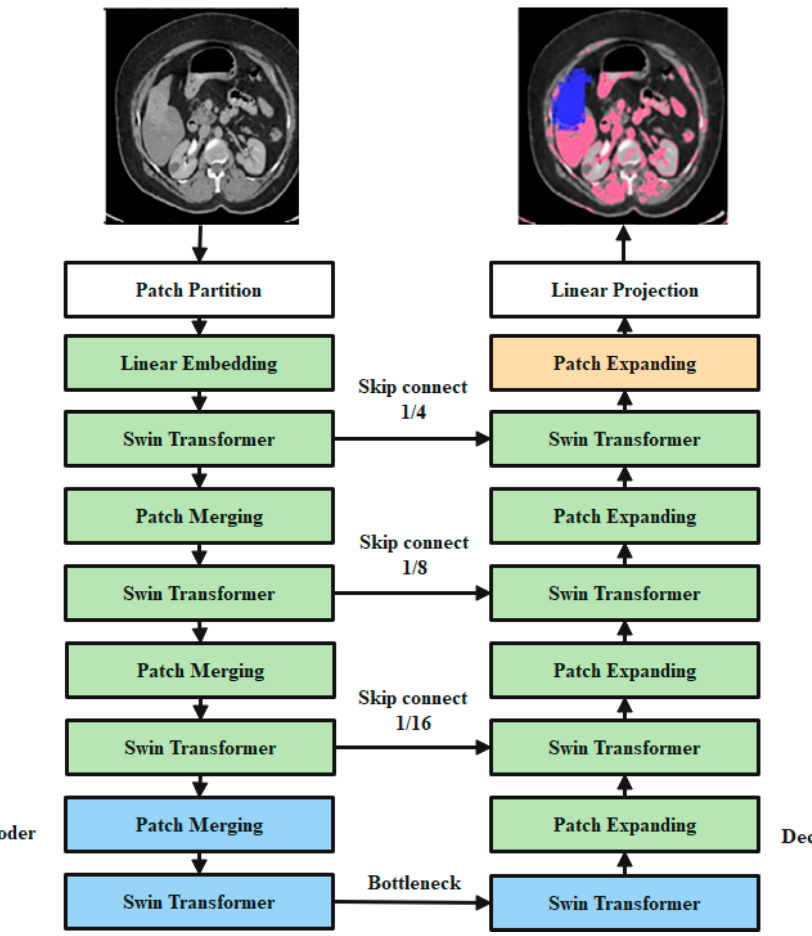
Figure 3. Encoders, bottleneck nodes, decoders, and skip links make up Swin-overall Unet’s structure. The swin transformer block is the foundation of the encoder, bottleneck, and decoder.